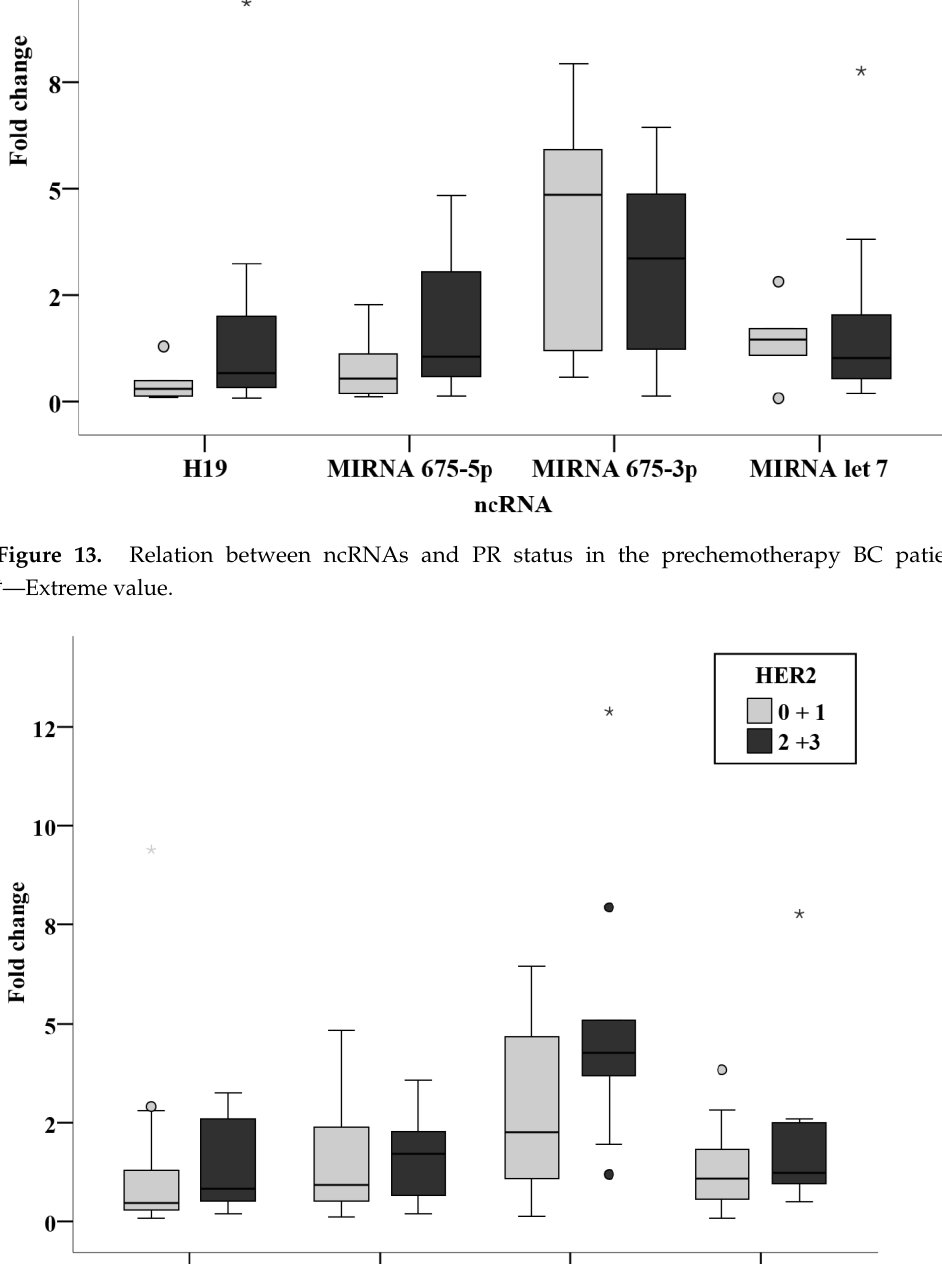
Figure 14. Relation between ncRNAs and HER2 status in the prechemotherapy BC patients. *- Extreme value.